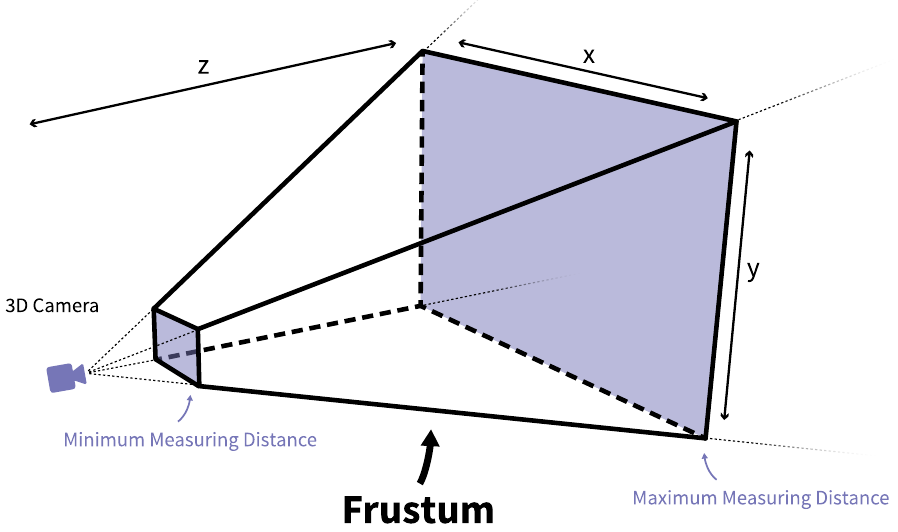
Figure A3. The Volume of the Field of View of a 3D Camera Described as a Frustum.